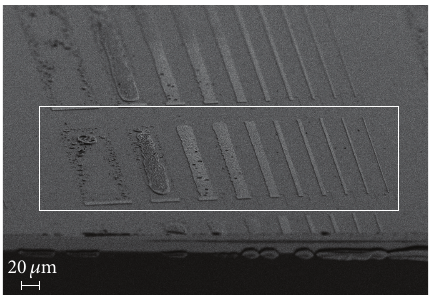
Figure3:SEMimageofRMGstraightstripsshowingagglomeration at large strip